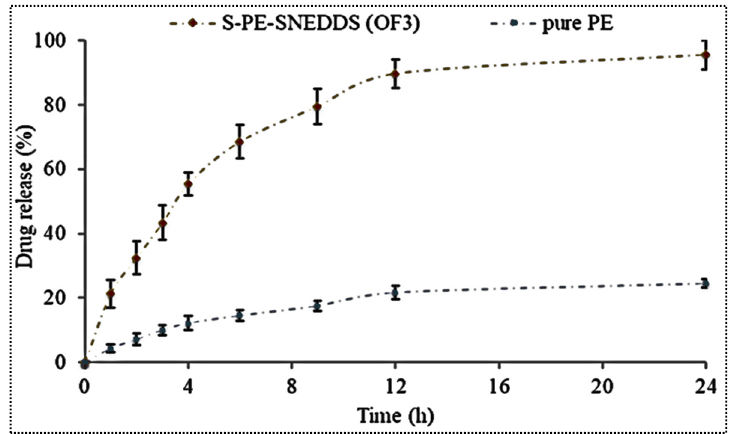
Figure 4. In-vitro release profile of SNEDDS and pure PE dispersion. Values are given as mean ± SD ( n = 3).